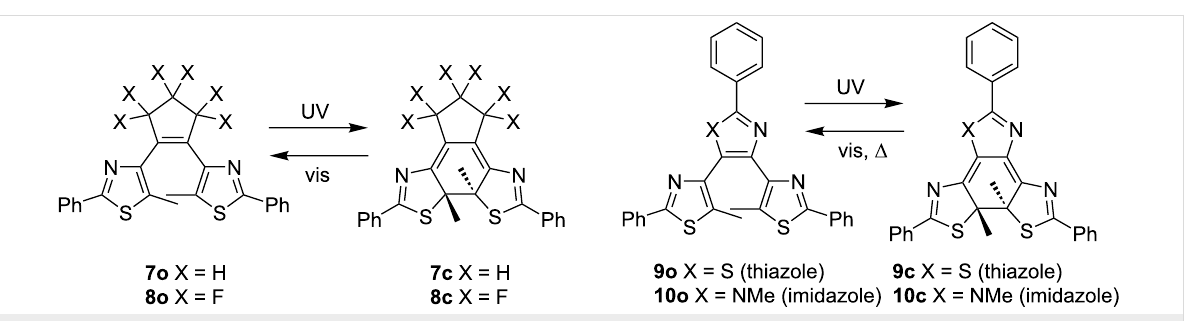
Scheme 4: Photochromism of closely related compounds.